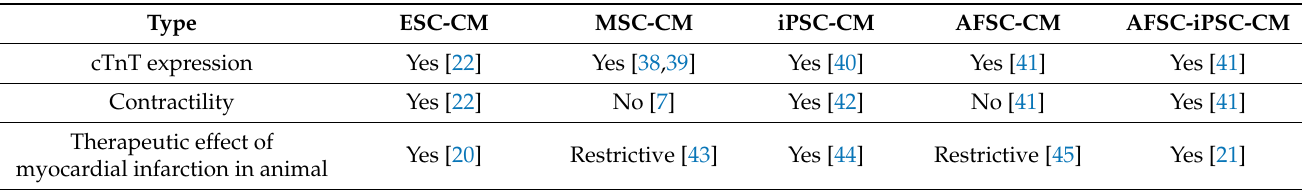
Table 2. Characterization of cardiomyocyte differentiation.